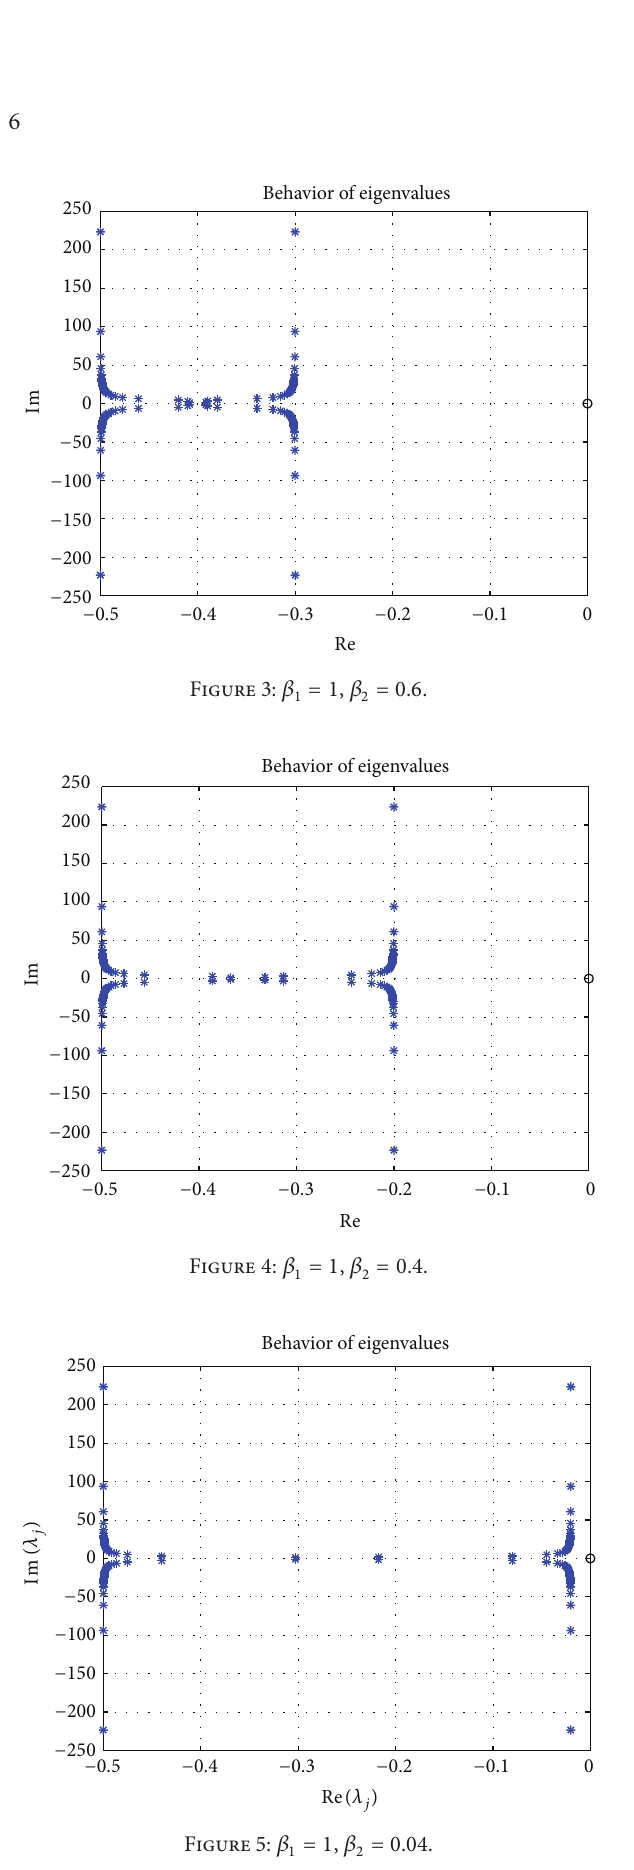
Figure 5: 𝛽 1 = 1 , 𝛽 2 = 0.04 .